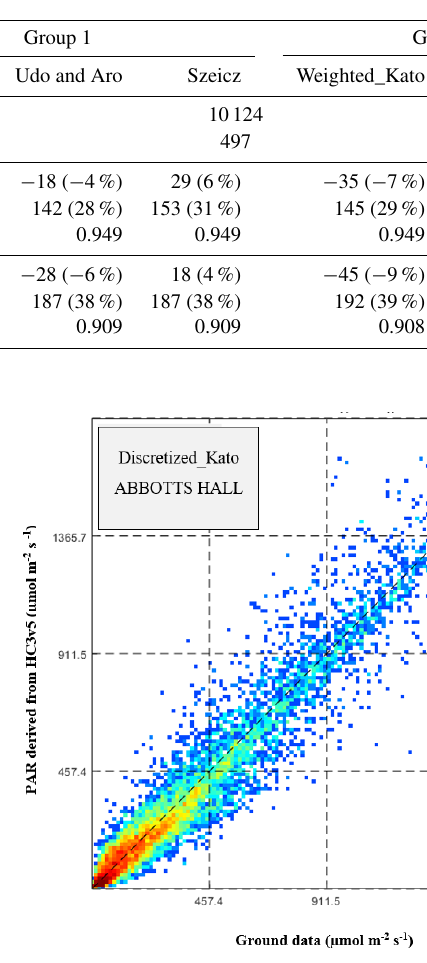
Figure 3. 2-D histogram of the PAR in-situ measurements (hori- zontal axis) and PAR derived from HC3v5 estimates using the Dis- cretized_Kato method (vertical axis) at Aberystwyth University.